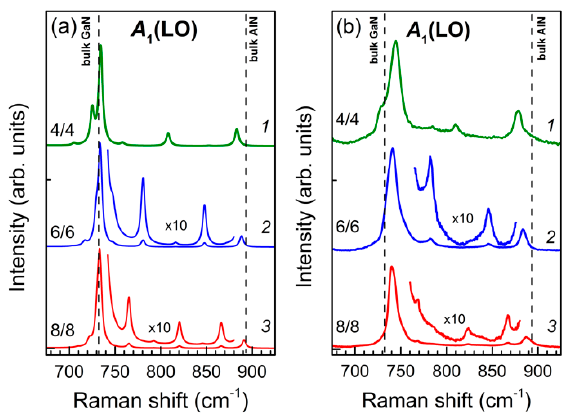
Figure 11. The high-frequency parts of the calculated ( a ) and experimental ( b ) z ( xx ) z Raman spectra for the (GaN) m /(AlN) n SLs with m / n = 4/4 ( 1 ), 6/6 ( 2 ) and 8/8 ( 3 ).